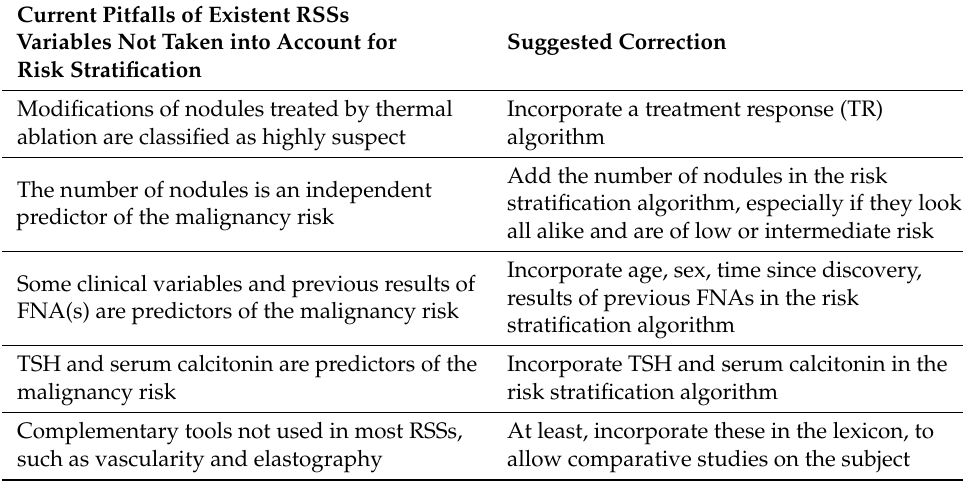
Table 3. Current pitfalls of most known risk stratification systems (RSSs) of thyroid nodules and recommendations to improve